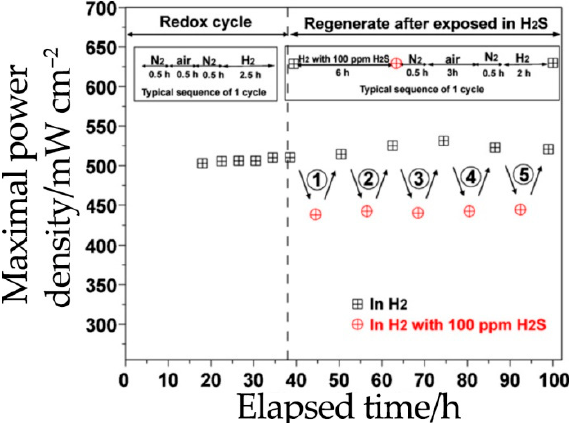
Figure 16. Short-term stability of the Sr 2 Fe 1.5 Mo 0.5 O 6– δ |LSGM|Sr 2 Fe 1.5 Mo 0.5 O 6– δ (SFM|LSGM|SFM) cell at 800 °C during a number of cycles: the first five cycles are redox changes, while other five correspond to a gradual replacement of H 2 with 100 ppm H 2 S/H 2 . Reproduced with permission [21]. Copyright 2011, Elsevier.